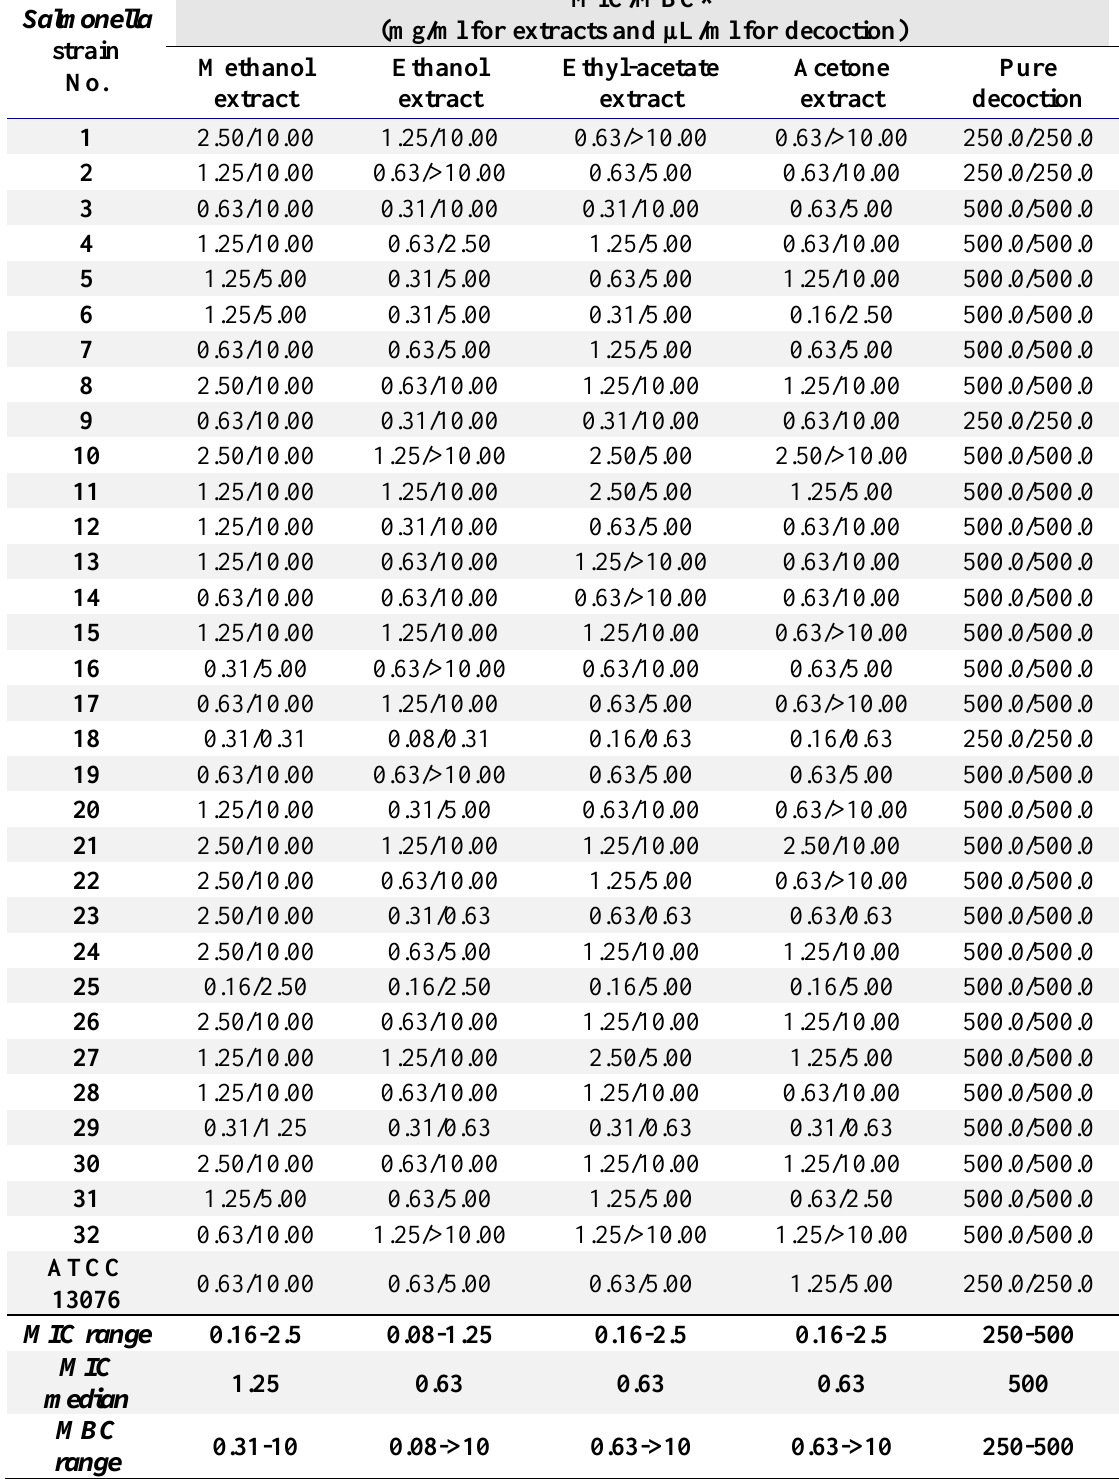
Table 3. Antimicrobial activity of Allium cepa dry scales extracts and decoction against Salmonella at 10 6 CFU/ml starting cell count (microdilution assay)